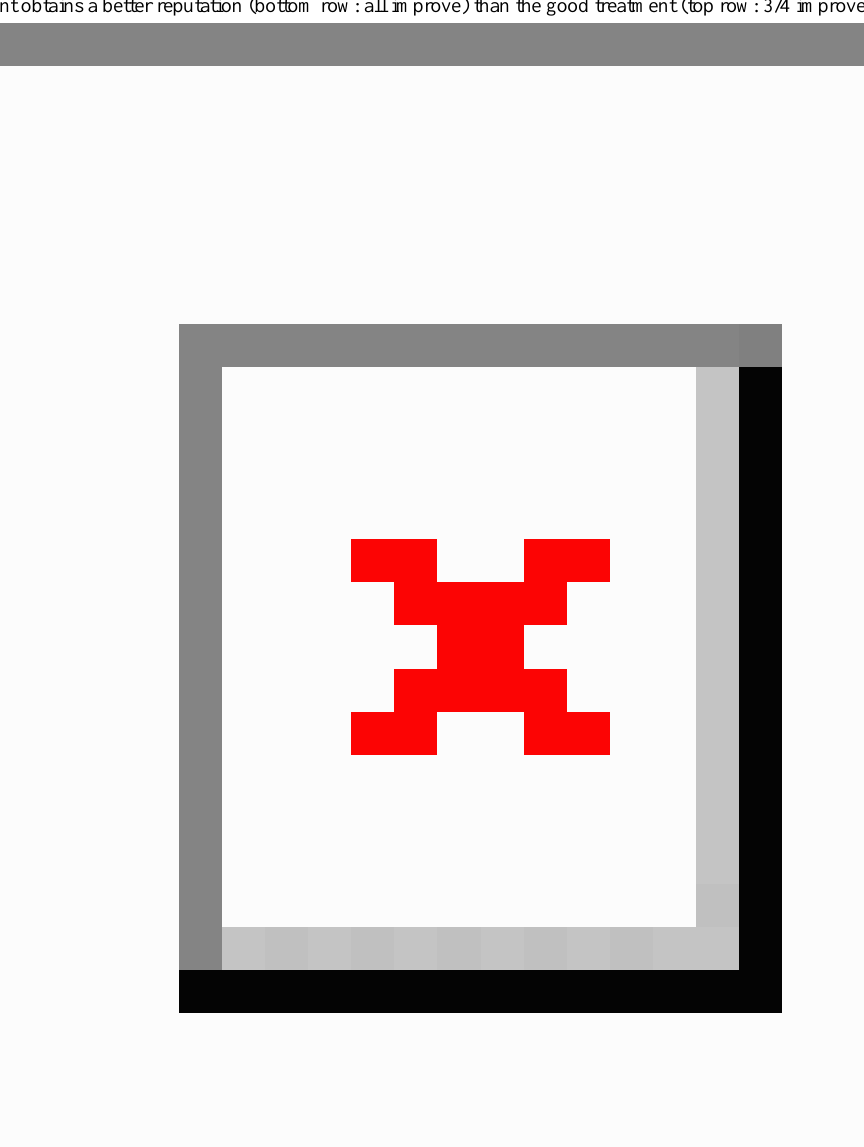
Figure 5. Hypothetical example illustrating the effect explored in the mathematical model. With a reporting bias that makes bad outcomes unobservable,